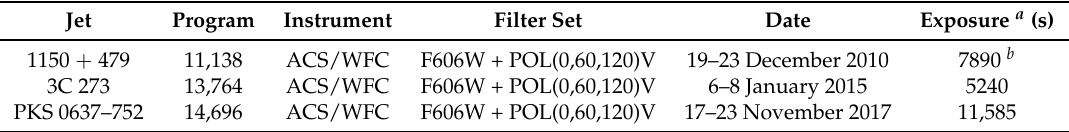
Table 1. Hubble Space Telescope ( HST ) Polarimetry